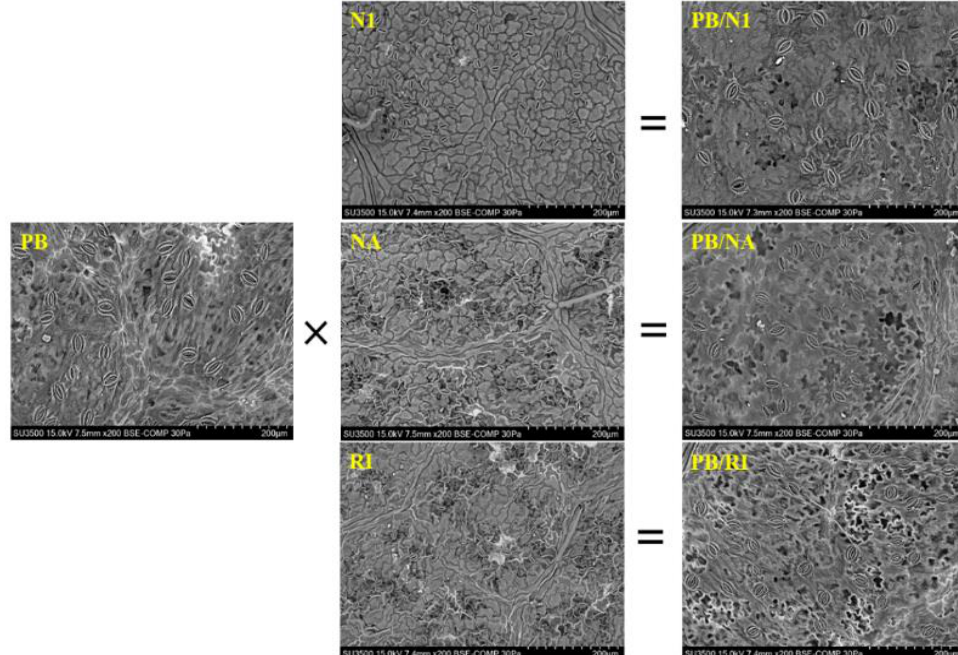
Figure 5. Stomatal images of one scion, three rootstocks, and three grafted plants taken with scanning electron microscopy in winter. (PB): scion cut rose of Rosa hybrida cv. Pink Beauty; (N1): rootstock of Rosa multiflora cv. Hort No 1; (NA): rootstock of Rosa canina cv. Natal brier; (RI): rootstock of Rosa indica cv. Major; (PB/N1): PB grafted onto N1; (PB/NA): PB grafted onto NA; (PB/RI): PB grafted onto RI.